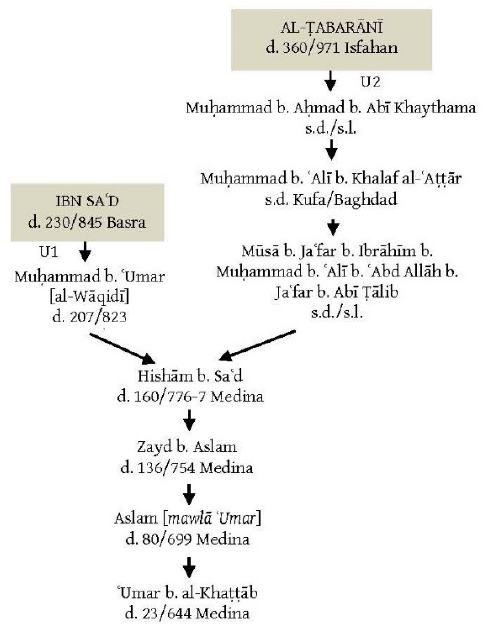
Figure 4. The isn¯ad bundle of Hish¯am b.